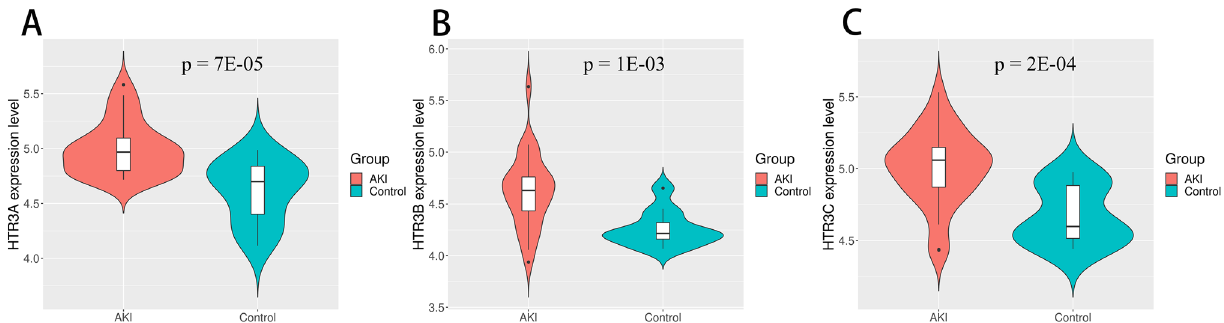
Figure 2. Changes of HT3 receptor genes (HTR3A, HTR3B and HTR3C) in patients with AKI compared with control (the pristine protocol